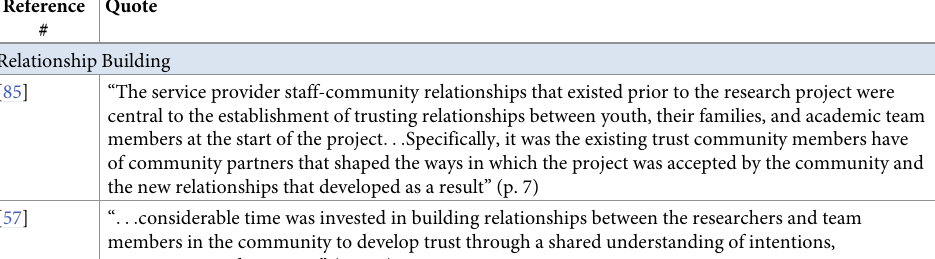
Table 3. Illustrative quotes of community engagement from empirical